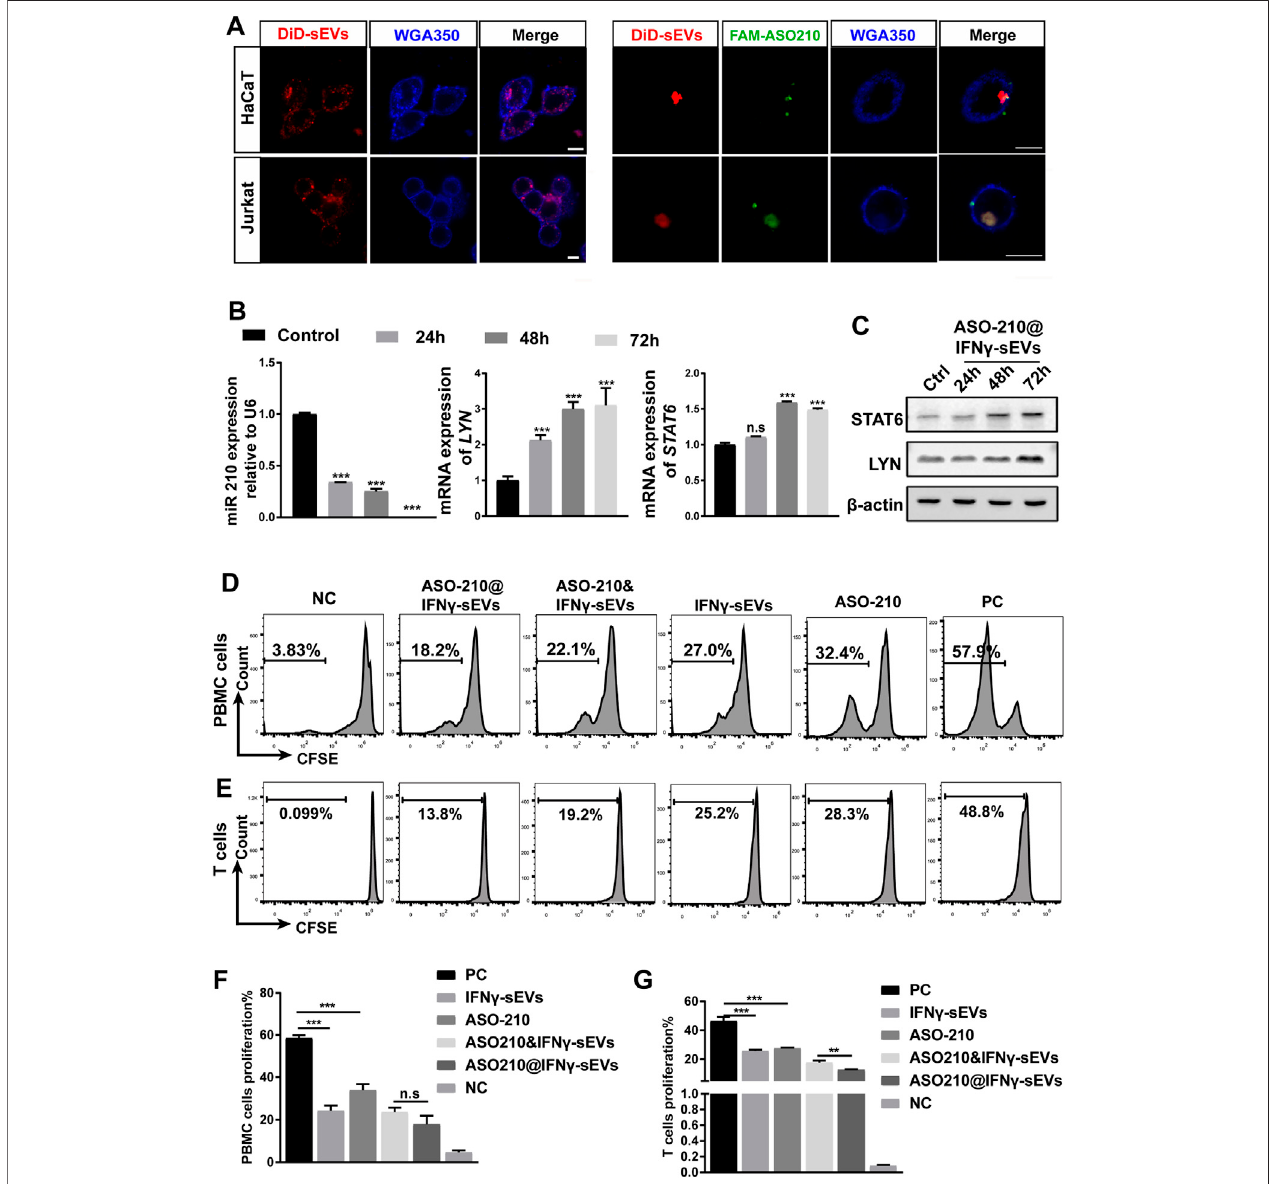
FIGURE 2 | ASO-210@IFN γ -sEVs inhibit the proliferation of PBMCs and T cells in vitro . (A) Representative confocal images of HaCaT and Jurkat cells when incubated with IFN γ -sEVs and ASO-210@IFN γ -sEVs. Scale bar: 10 μ m. (B) Representative quantitative analysis of the effect of ASO-210 at time points on the mRNA expression of miRNA-210, STAT6 , and LYN in Jurkat T cells (n = 3). (C) Representative Western blot of ASO-210 at time point on the expression of STAT6 and LYN in Jurkat T cells. (D,E) Flow cytometry analysis of the proliferation of PBMC or T cells in groups that received different treatments (IFN γ -sEVs, ASO-210, ASO- 210&IFN γ -sEVs,andASO-210@IFN γ -sEVs)for5days.ThePCgroupstandsforPBMCorTcellsculturedforthesamedayswithoutdrugs.NCgroupstandsforPBMC or T cells on day 0. (F,G) The corresponding quantitative analysis of PBMC or T cells from different treatment groups (n = 3). Error bar, mean ± SD. n.s represents no signi fi cance, * p < 0.05, ** p < 0.01, *** p < 0.001.